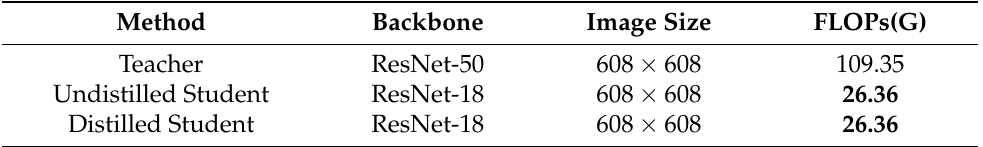
Table 4. The calculation complexity of our methods. Bold numbers in the table mean the best results.